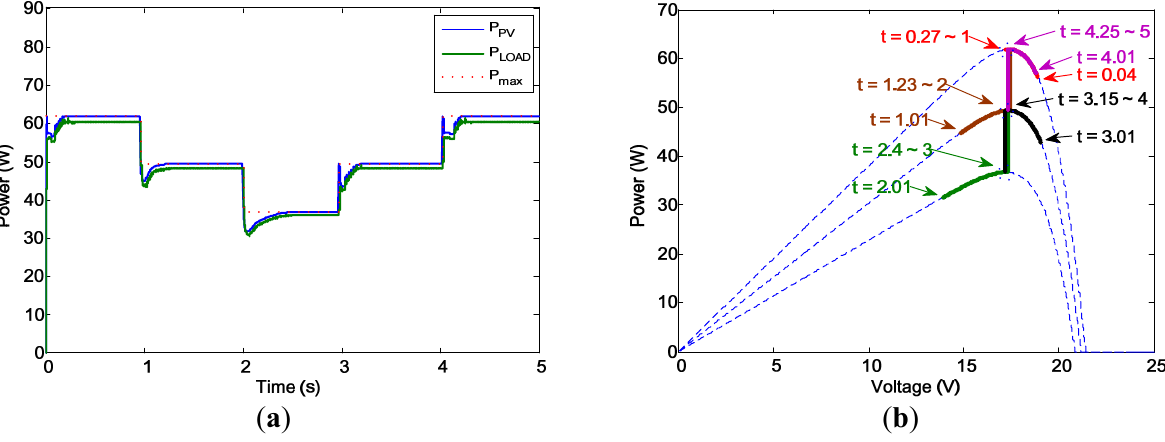
Figure 18. ( a ) Power output from PV model and power at the load terminal; ( b ) Power output from PV model versus PV